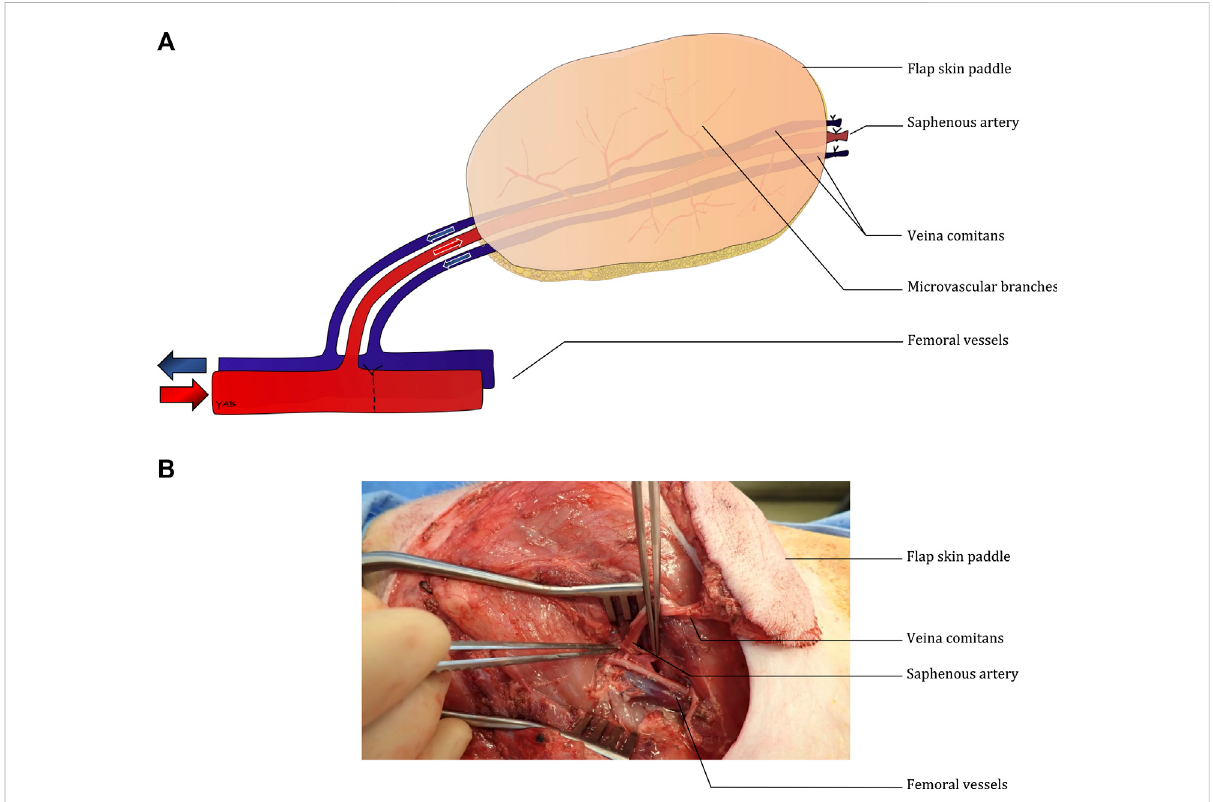
FIGURE 1 Diagram describing the surgical model (A) and intra-operative picture of the bilateral fasciocutaneous fl aps (B) .